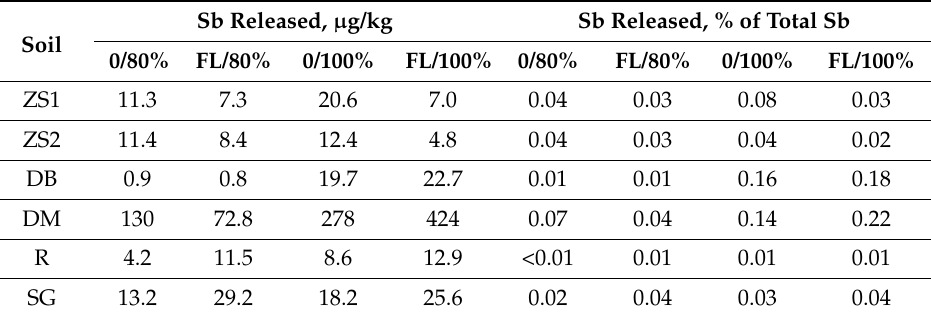
Table 3. The amounts of Sb released from soils into pore water.